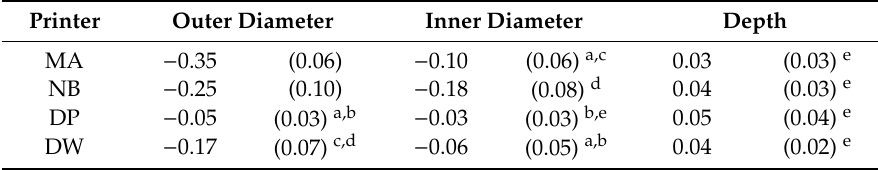
Table 2. The deviation (mm) from the design value of the inner and outer diameters and the depth of fabricated